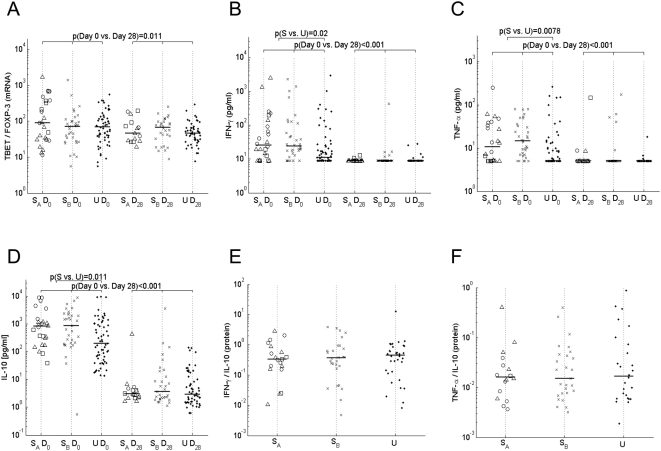
Ratios of Th1 over Treg cells and pro-inflammatory over regulatory cytokines.(A) Ratio of the mRNA level of the Th1 transcription factor T-BET over FOXP3 for uncomplicated and severe cases during the acute phase (D0) and convalescence (D28) as determined by RT-PCR. Plasma levels for (B) IFN-γ, (C) TNF-α, and (D) IL-10 measured with a bioplex system and the ratios of (E) IFN-γ/IL-10 protein as well as (F) TNF-α/IL-10 protein on day 0. (NB: Protein ratios could not be calculated for Day 28, since cytokine concentrations were rarely above the detection limit of the assay. In Figure 5E and 5F only ratios for samples that had detectable responses for both cytokines on Day 0 are shown) Symbols, bars and p-values as defined in Figure 1.